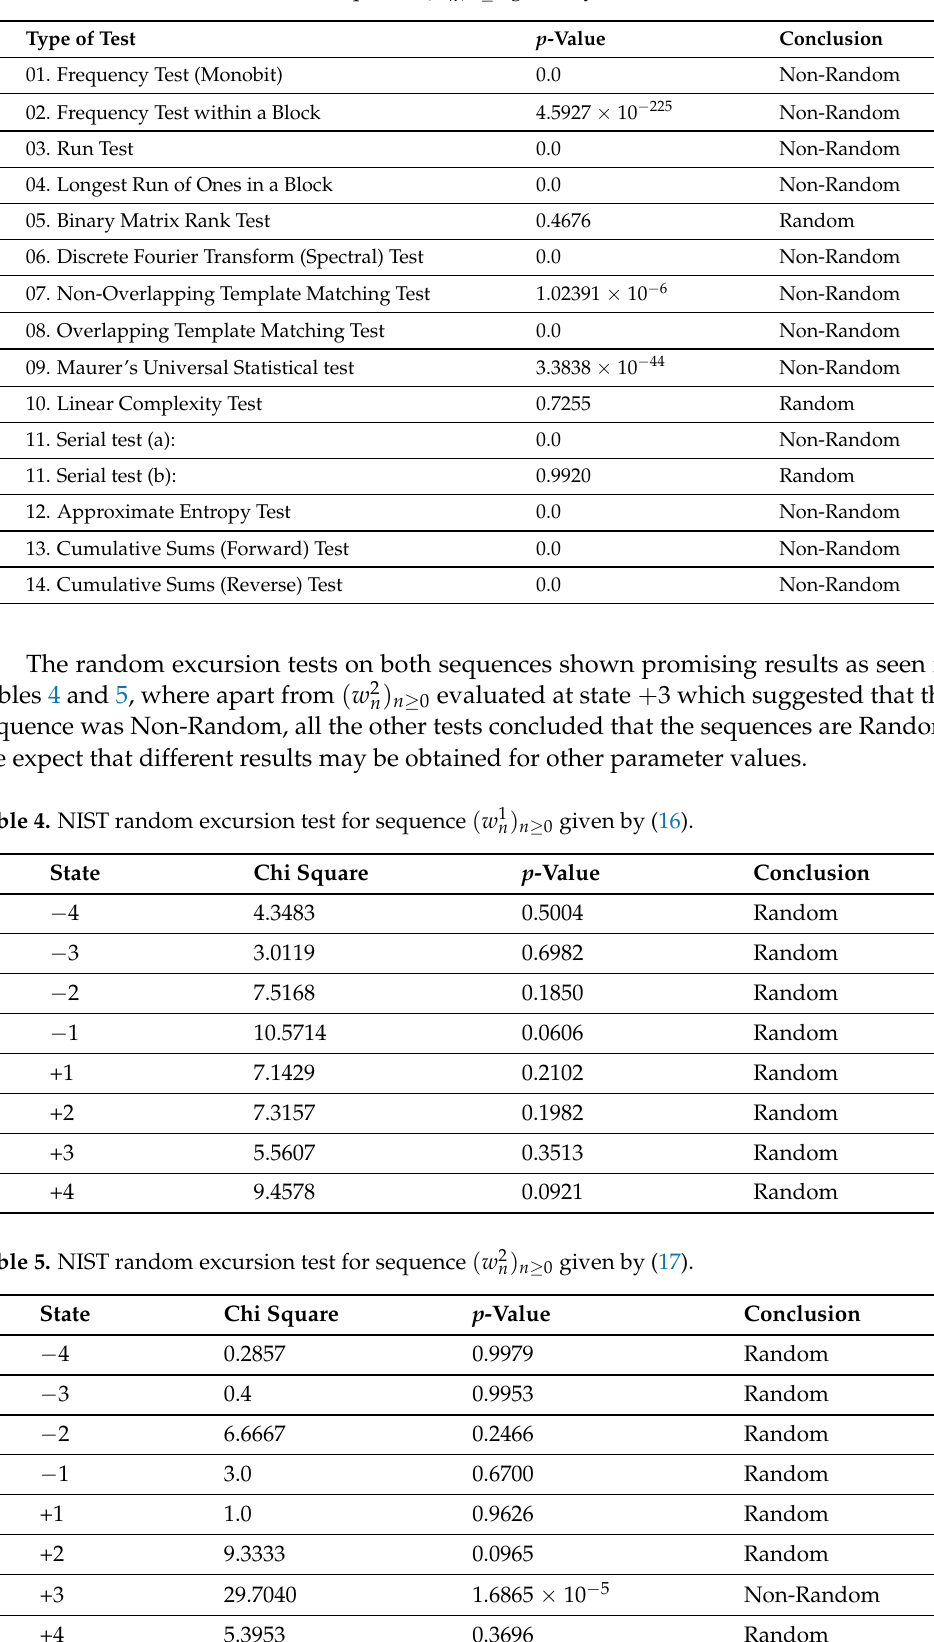
Table 3. NIST randomness tests for sequence ( w 2 n ) n ≥ 0 given by (17).